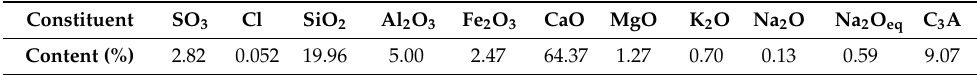
Table 3. Composition of cement used for